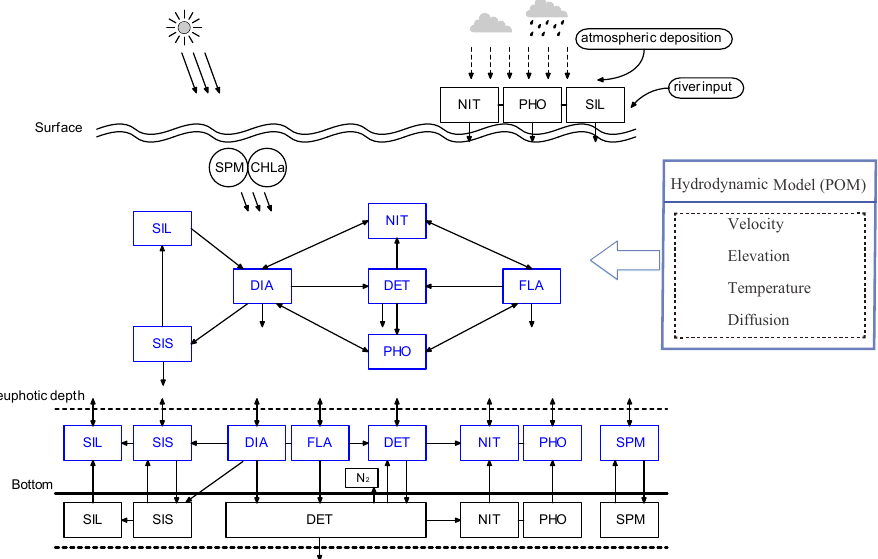
Fig.2 Fig. 2. Schematic illustration of the biophysical model that has a hydrodynamic module and a biological module. The hydrodynamic module is based on the Princeton Ocean Model (POM) (Mellor, 2003). The biological module includes three elements of nutrients (dissolved inor- ganic nitrogen (DIN), dissolved inorganic phosphorus (DIP), and silicate (SIL)), two types of phytoplankton (diatoms (DIA) and flagellates (FLA)), and two types of biogenic organic materials (dead organic matter containing nitrogen and phosphorus (DET) and biogenic silica (SIS)). See text for the processes included in this